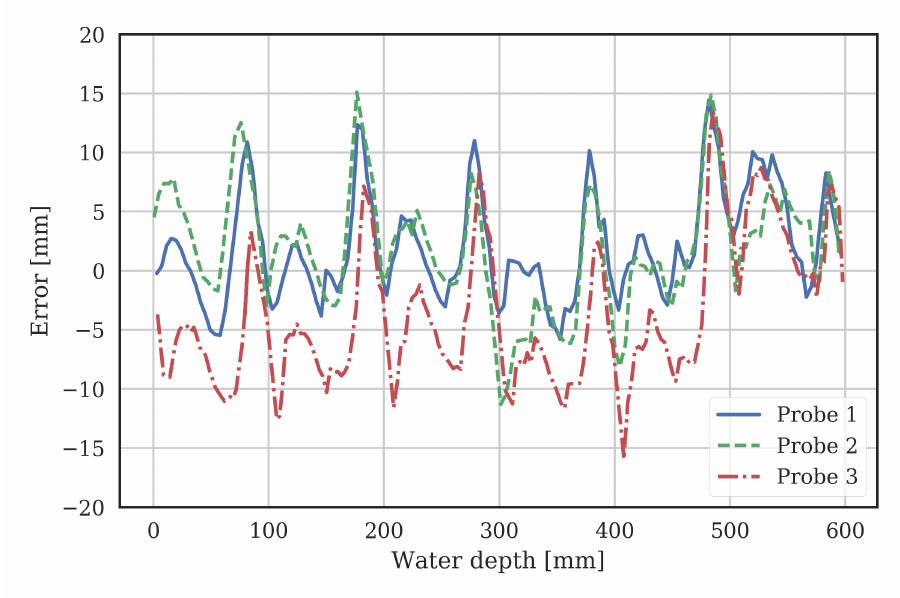
Figure 5. The error between actual (using the ultrasonic sensor) and calculated (using the VWC data from the MCP processed using the tangent model) water depth from 3 additional independent